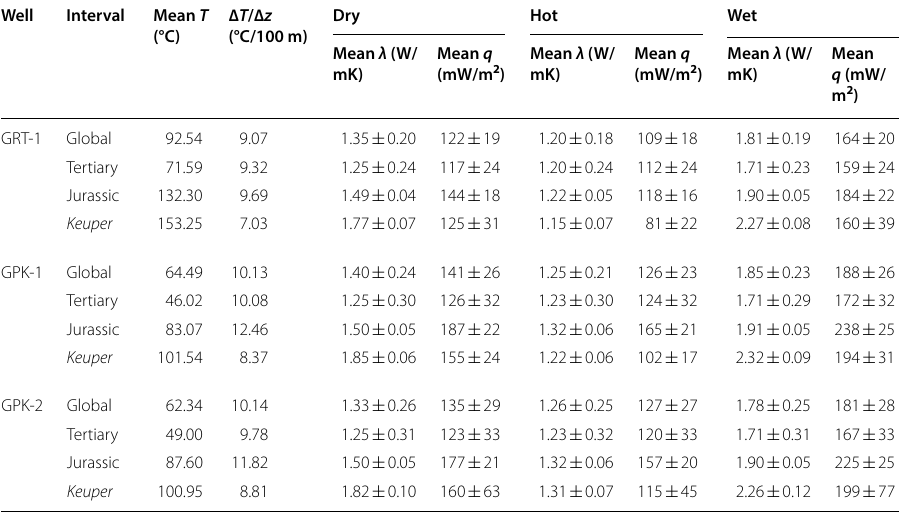
Mean measured temperatures and temperature gradients are given for the various intervals [global (from surface to top of the Muschelkalk ), Tertiary, Jurassic and Keuper ]. Data for dry rocks at ambient temperature (dry), dry rocks at in situ temperature (hot) and saturated rocks at ambient temperature (wet)